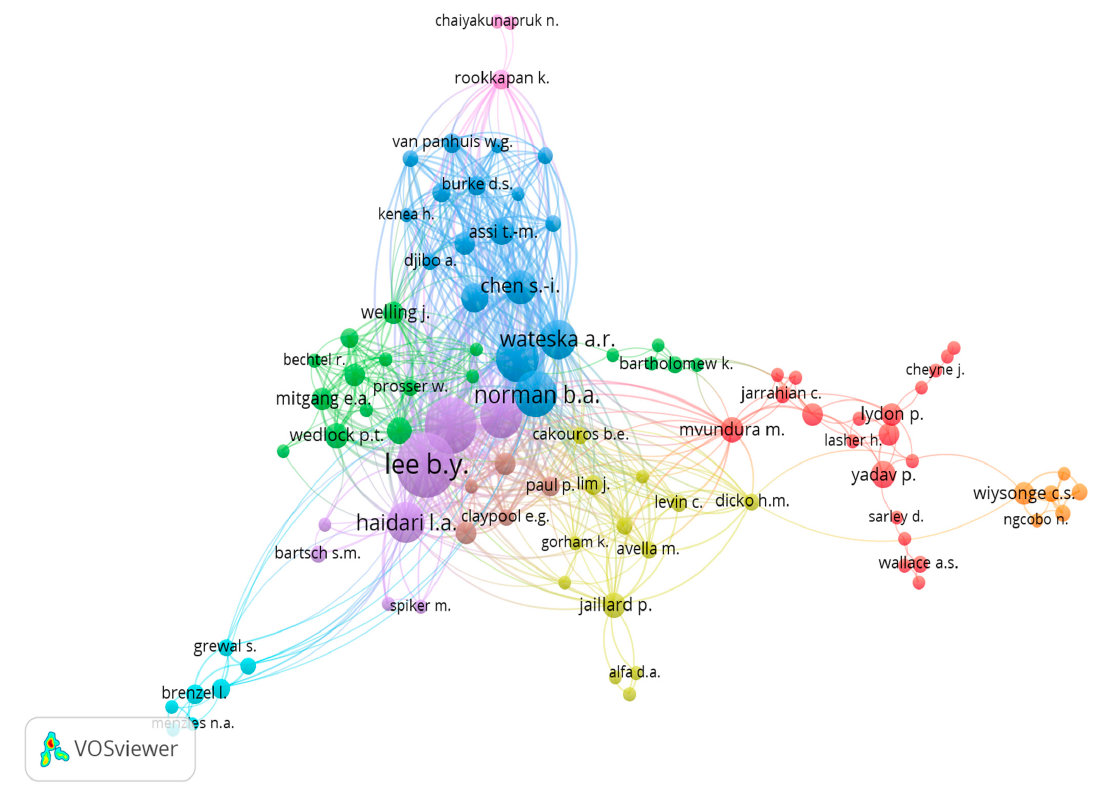
Figure 4. Collaboration map of the authors.